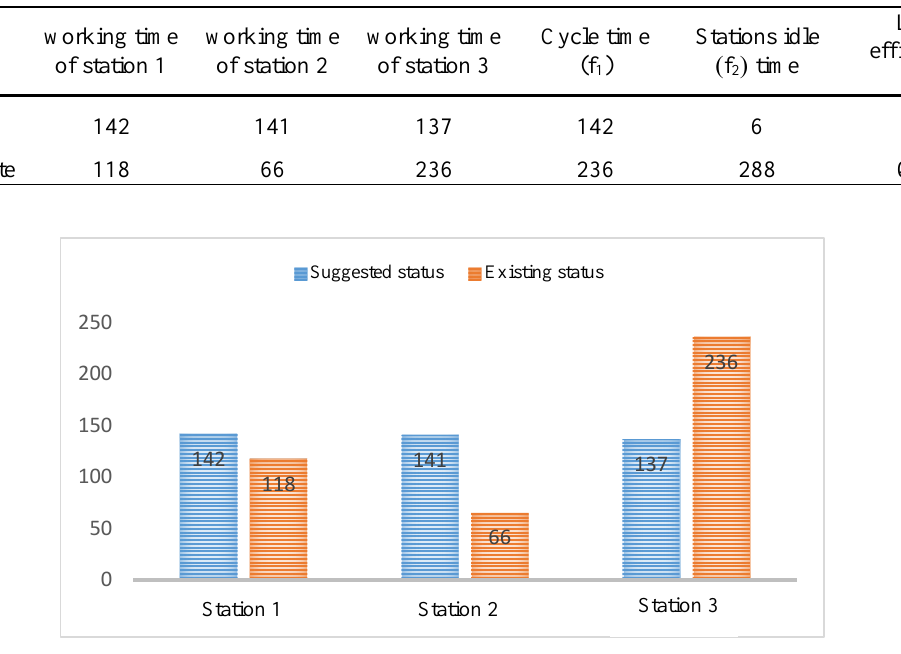
Figure 3. The degree of uniformity and smoothness of the line in the position before and after the implementation of the proposed